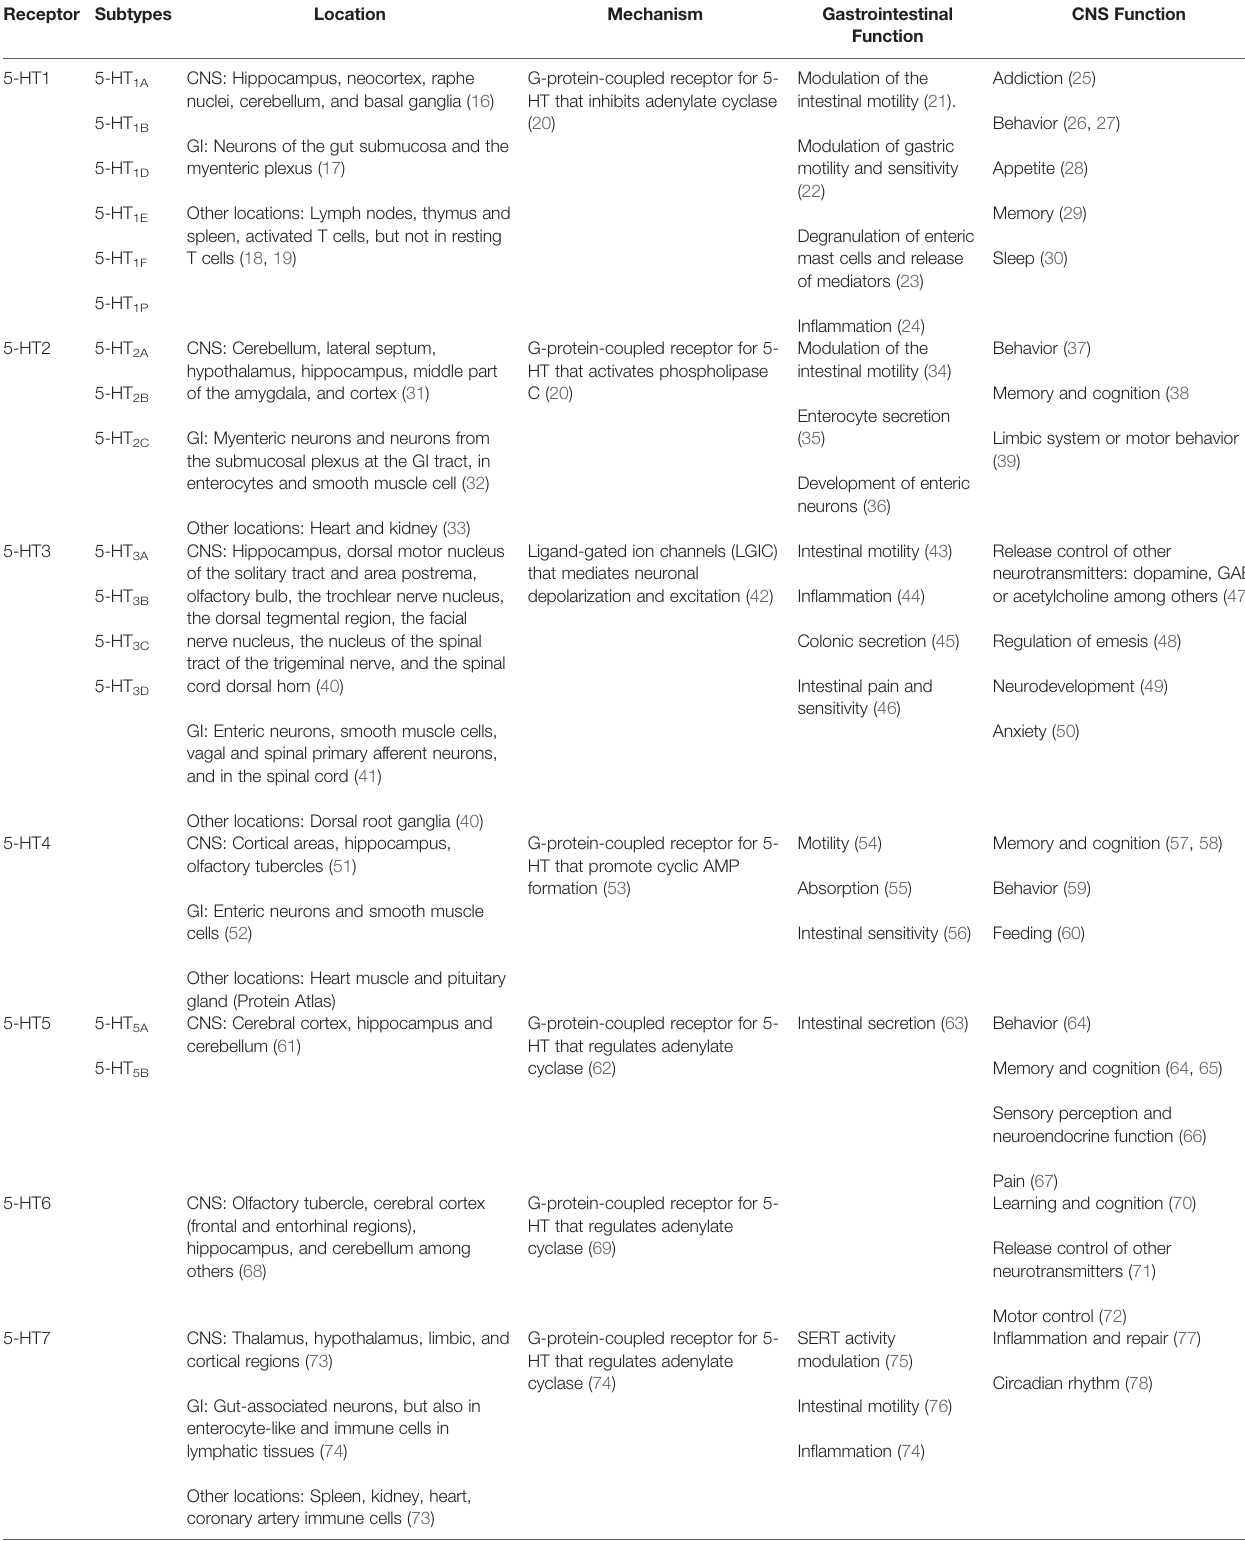
TABLE 1 | 5-HT receptors. Receptor